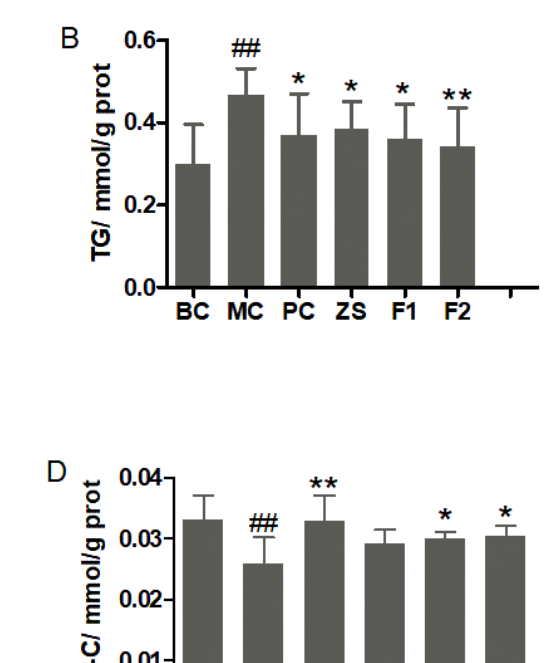
(A)TC; (B)TG; (C)LDL-c;